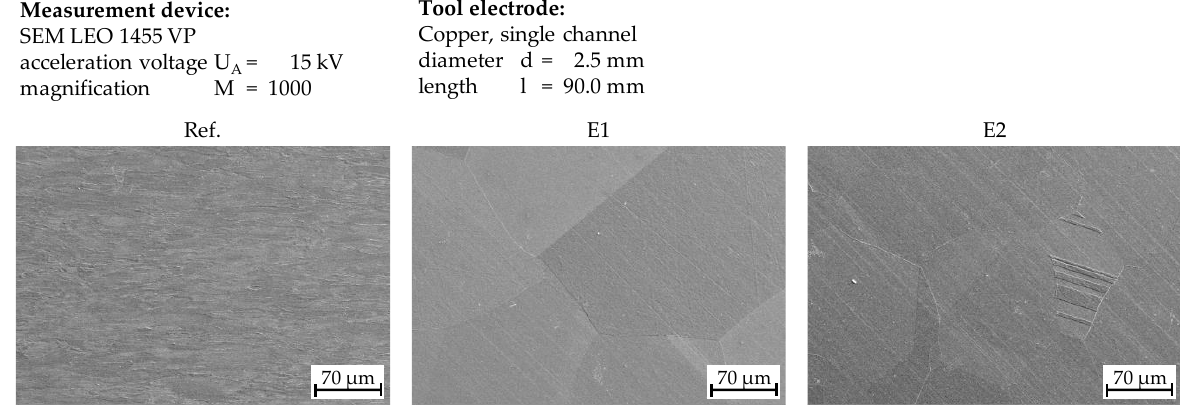
Figure 4. Cross-sections of oxidized tool electrodes. The reference electrode composed of small grains was elongated by wire drawing along the horizontal axis during its fabrication. This resulted in a grain size (s gRef ) of 57 µ m with an aspect ratio (a) of 7.8 along this axis. The oxidation temperature ( ϑ oxi ) of up to 900 ◦ C led to recrystallization and additional grain coarsening, resulting in increased grain sizes: s gE1 = 137 µ m and s gE2 = 106 µ